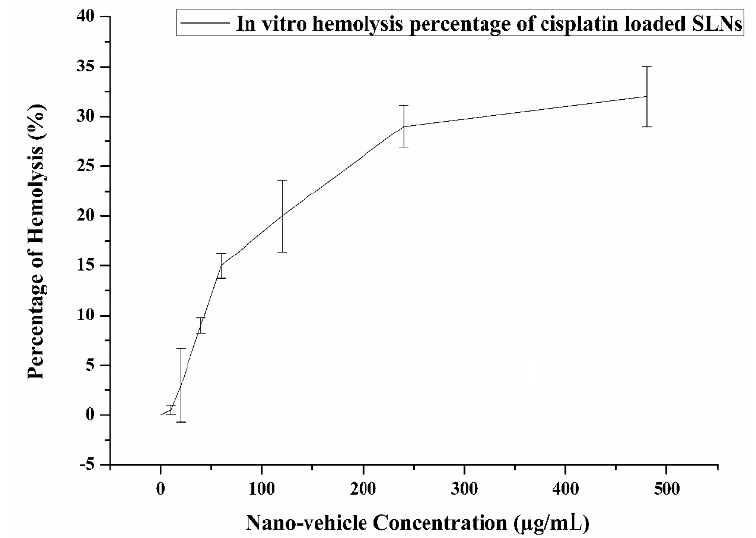
Figure 5. In vitro hemolysis percentage of cisplatin-loaded